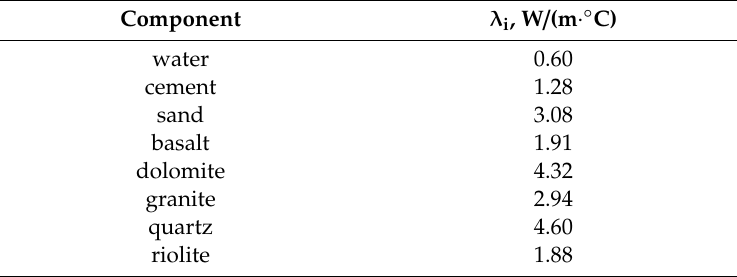
Table 5. Thermal conductivity λ i for concrete components, on the basis of